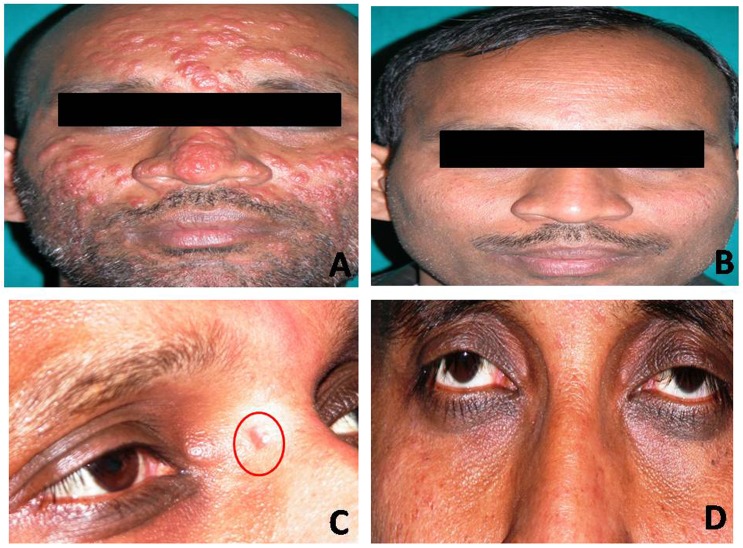
A PKDL patient (Case 11, table no. 3) that relapsed after MIL treatment and was subsequently cured with AmB.Papulo-nodules present on face before treatment (A), and complete regression after 3 months of MIL treatment (B), relapse at 13 months after completion of MIL treatment with papules on the root of nose (C), and cured after treatment with AmB (D).